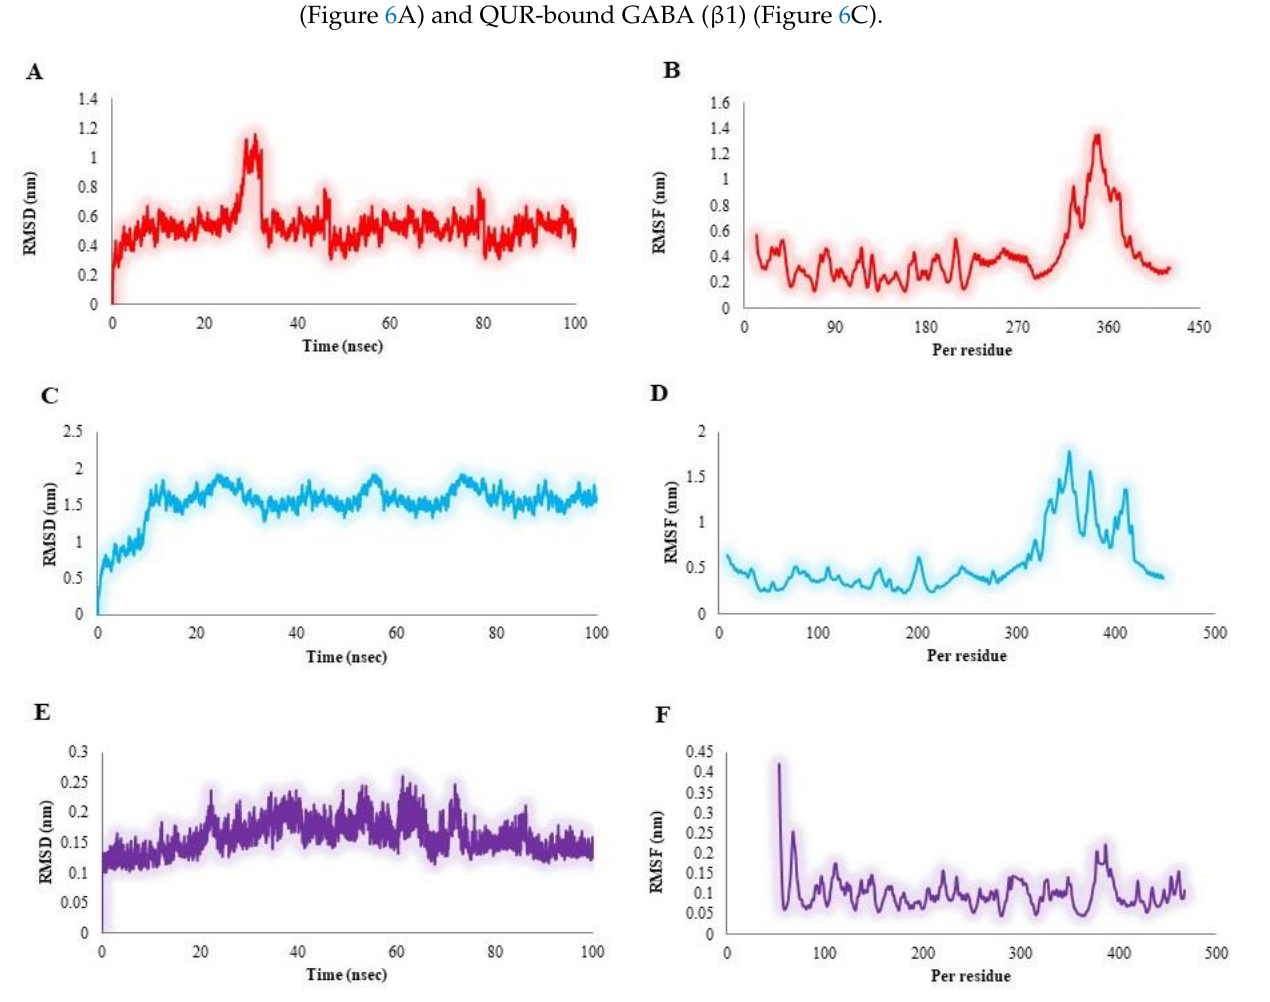
Figure 6. Time evolution of the RMSD values for the complexes of ( A ) backbone atoms of GABA ( α 5) in QUR-bound GABA ( α 5) complex, ( B ) residue variation in QUR-bound GABA ( α 5), ( C ) backbone atoms of GABA ( β 1) in QUR-bound complex, and (E) backbone atoms of GABA ( β 2) in QUR-bound complex. ( D ) Residue variation in QUR-bound GABA ( β 1). RMSF values for the complexes of ( A ) backbone atoms of GABA ( α 5) in QUR-bound GABA ( α 5) complex, ( C ) backbone atoms of GABA ( β 1) in QUR-bound complex, ( E ) backbone atoms of GABA ( β 2) in QUR-bound complex, and (F) residue variation in QUR- bound GABA (β2).